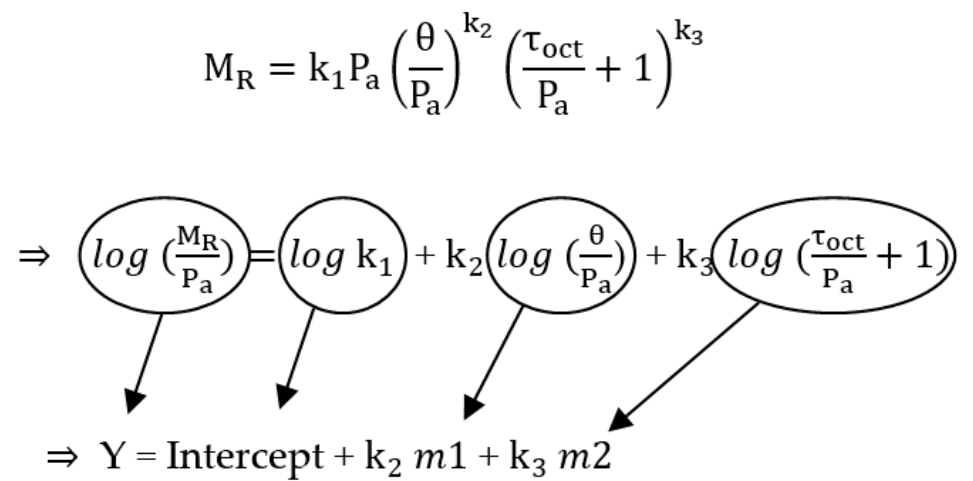
Figure 5. Logarithmic function of Equation (1) .